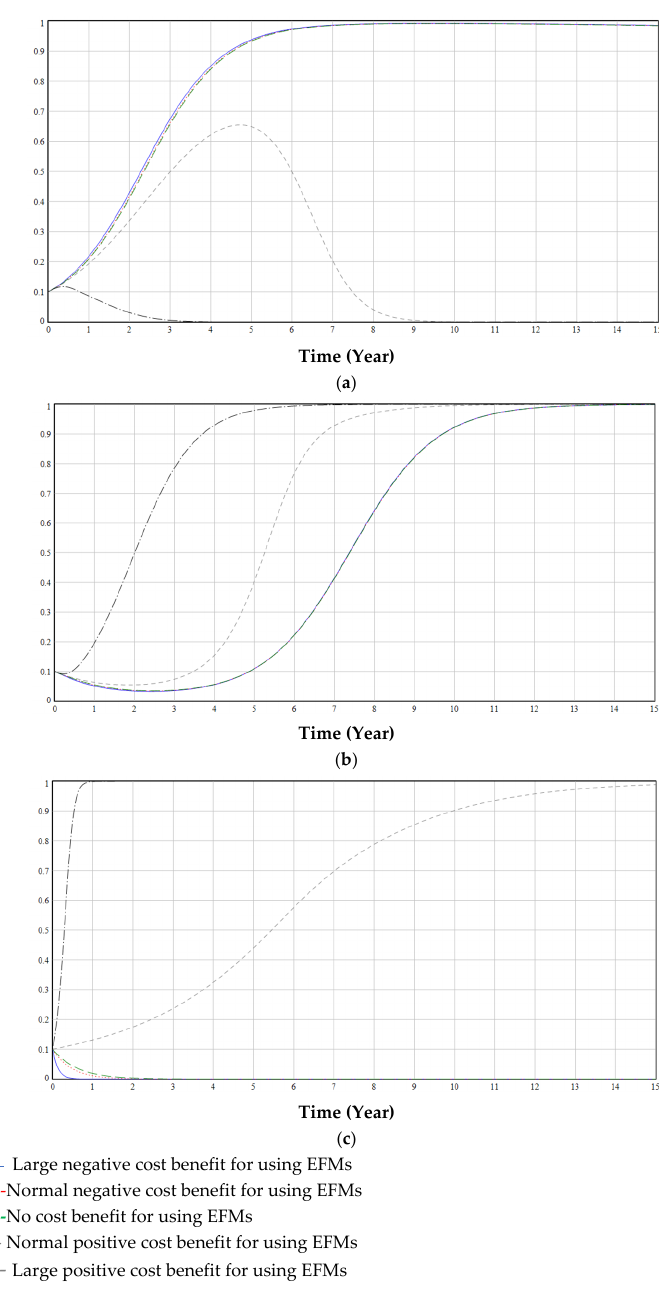
Figure 14. The effect of r c on decisions of government ( a ), enterprises ( b ), and medical institutions ( c